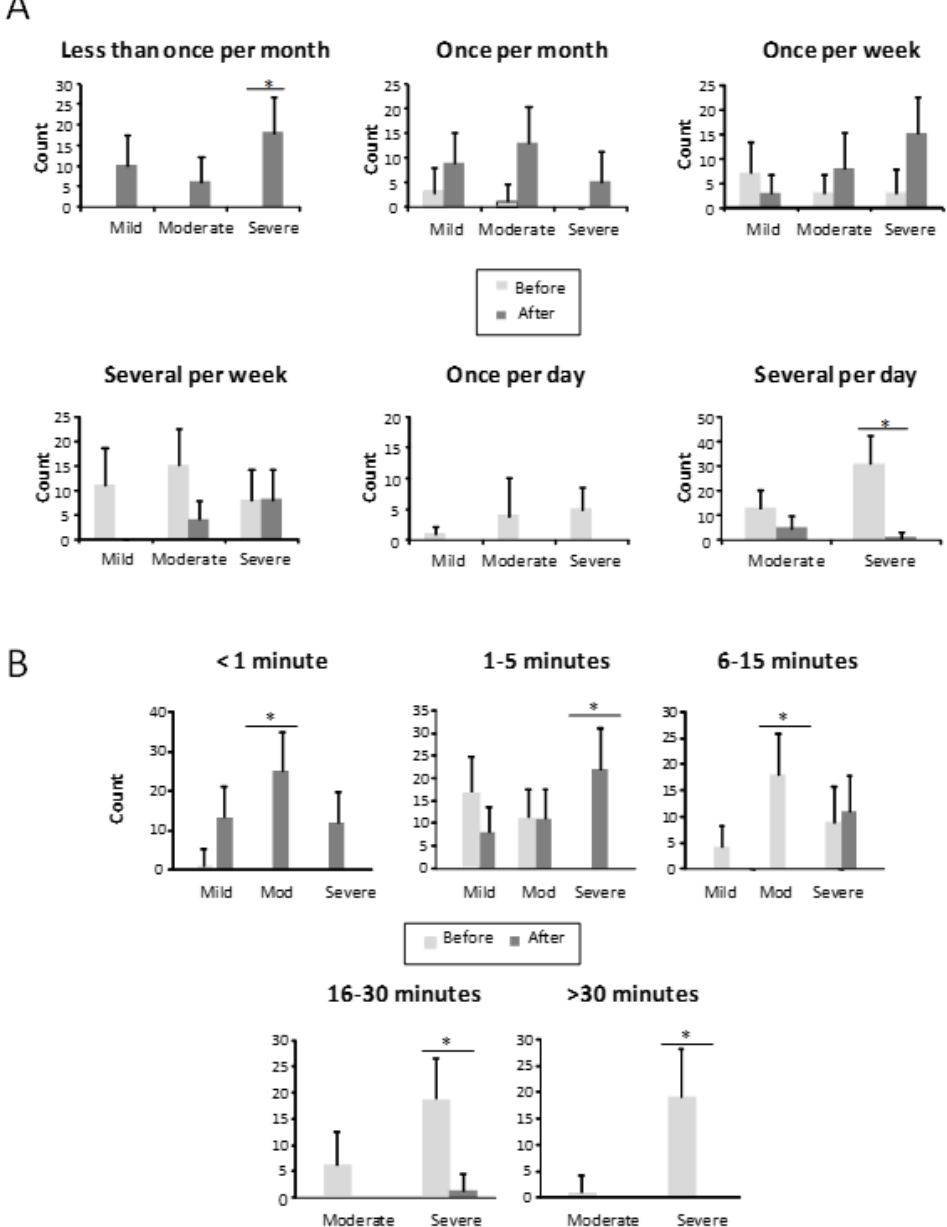
Figure 2. ( A ) Frequency of epistaxis, in the different groups, before and after the treatment in mild, moderate, and severe HHT-ESS patients. * p < 0.05. ( B ) Bleeding time of patients in each class, before and after the treatment in mild, moderate, and severe HHT-ESS patients. * p < 0.05.